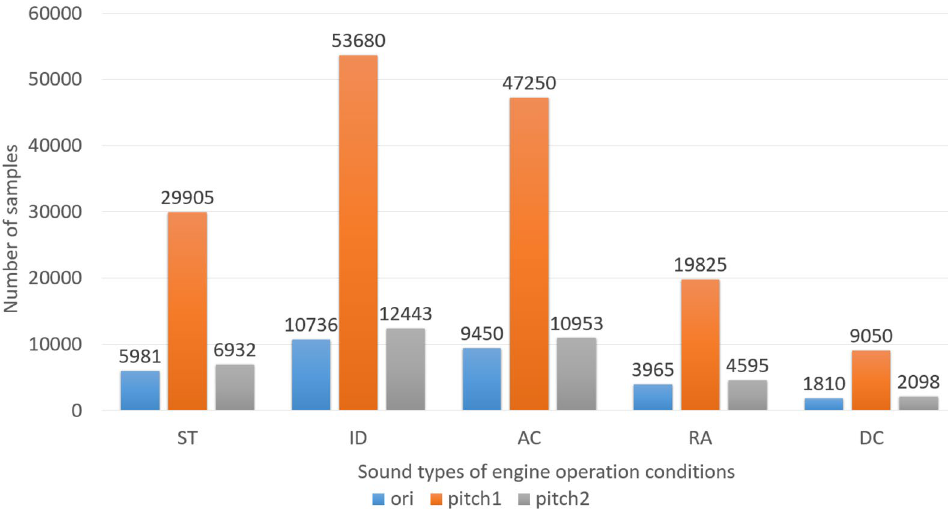
Figure 12. Comparison of sample numbers of engine sound dataset enhanced by different methods. ST Starting, ID Idling, AC Accelerating, RA Rapidly accelerating, DC Decelerating.